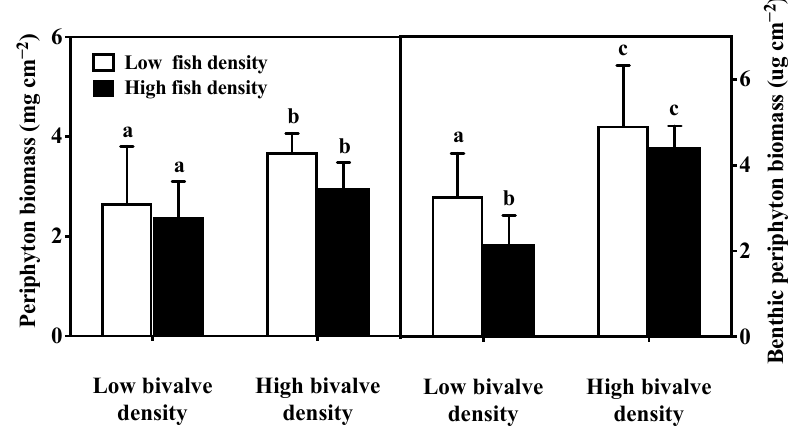
Figure 8. Periphyton biomass and Chl a of benthic algae in the different treatments at the end of the experiment (means ± SD). Different letters show significant differences among treatments.